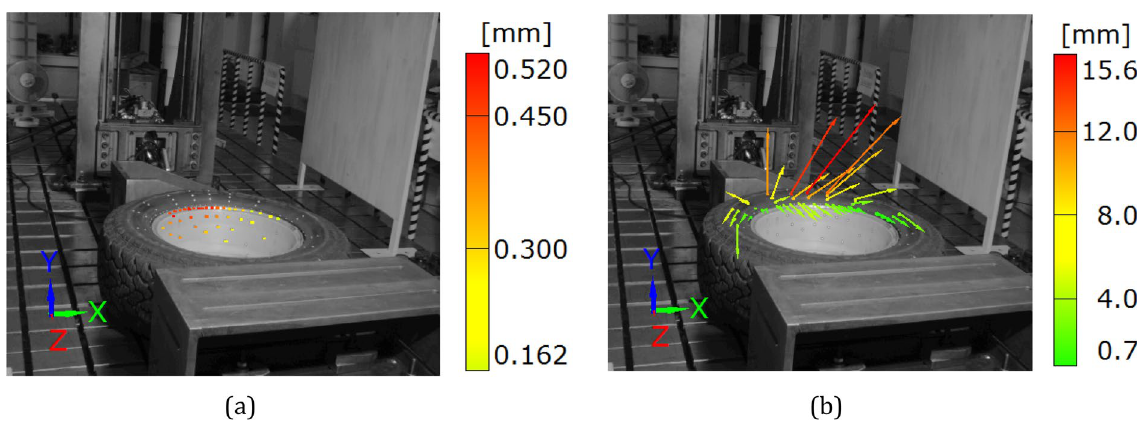
Figure 9. Distributions of the resultant vectors of deflection in the SUV wheel under the force of 11 kN for the rim ( a ) and tire ( b ).